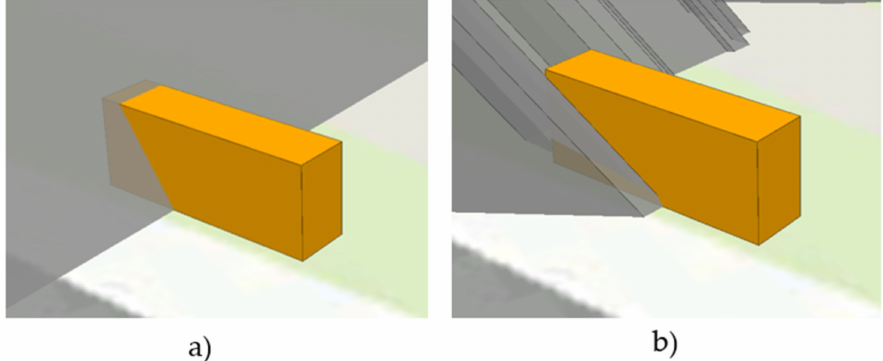
Figure 22. Specific relationships between the shadow cast by the buildings (grey) and the tram shelter (orange): ( a ) partial shading; ( b ) partial shading, but the overlapping part does not include any part of the shelter